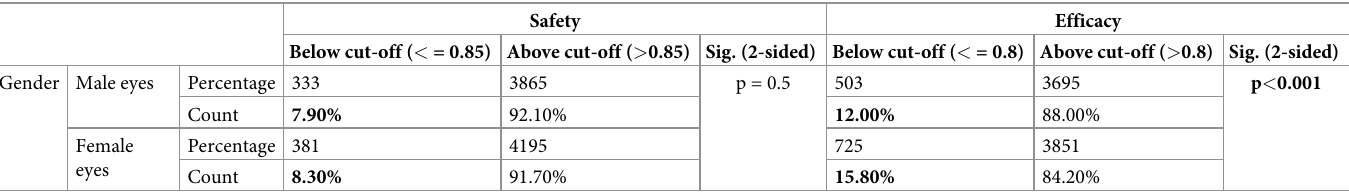
Table 5. Correlation between gender and safety and efficacy (Pearson Chi-Square).